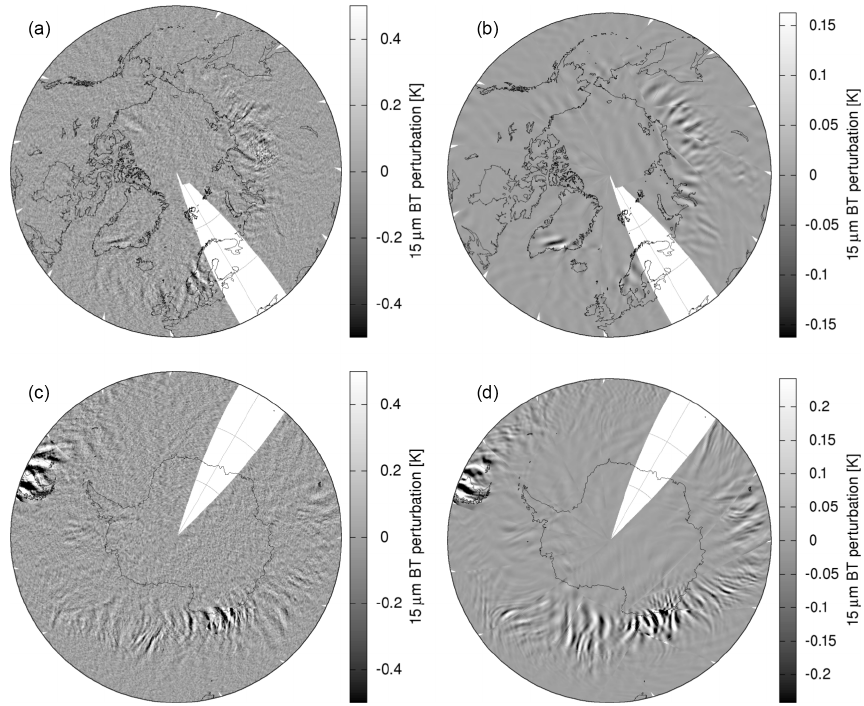
Figure 9. AIRS measurements of 15µm brightness temperature perturbations (left) and corresponding simulations based on ECMWF op- erational analysis temperatures (right). Real measurements took place on 11 December 2003 from 12:00 to 24:00UTC in the Northern Hemisphere (top) and on 22 July 2011 from 00:00 to 12:00UTC in the Southern Hemisphere (bottom). Simulated measurements are based on synoptic data at 18:00 and 06:00UTC, respectively. The color bar ranges are scaled individually for better comparisons of the wave patterns.